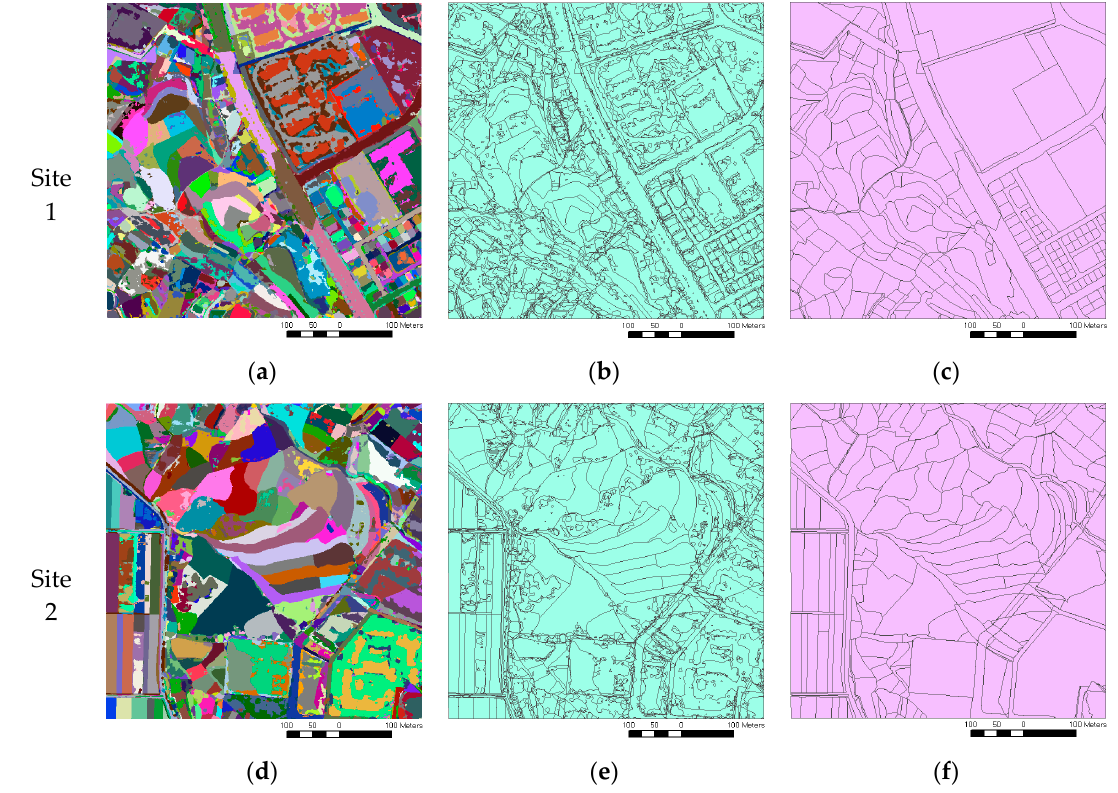
Figure 11. Result of the proposed process: ( a ) combined raster map of Site 1, ( b ) combined vector map with attributes of Site 1, ( c ) discrepancy map of Site 1, ( d ) combined raster map of Site 2, ( e ) combined vector map with attributes of Site 2, and ( f ) discrepancy map of Site 2.